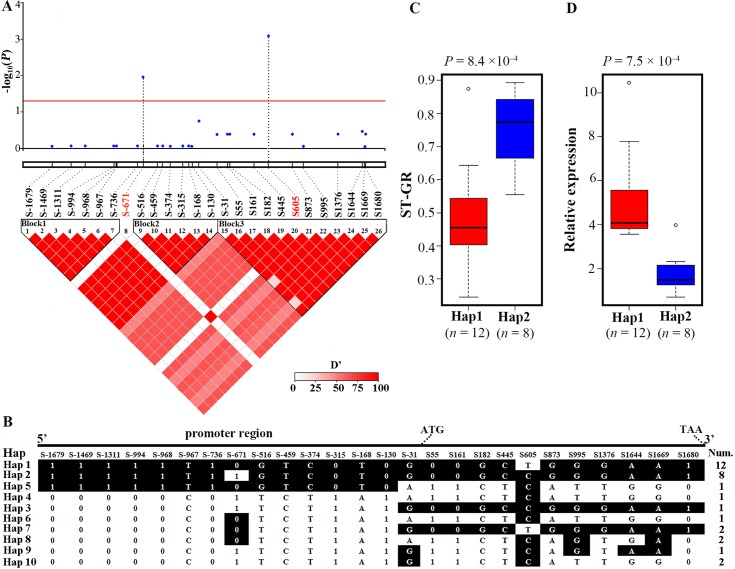
Natural variations in GmCDF1 are significantly associated with salt tolerance indices in 31 soybean accessions.(A)
GmCDF1-based association mapping and pairwise LD analysis (bottom) for GmCDF1. The red solid line represents the significance threshold (−log10(P) = 1.32). The blue dots above the red solid line represent significant variants for ST-GR (P < 0.05), and these are connected to the pairwise LD diagram with a black dashed horizontal line. The inverted triangle is the linkage disequilibrium (LD) plot between the GmCDF1 SNPs. The physical position of each SNP is shown above the plot. The magnitude of LD indexed by the D’ statistic is shown. (B) Haplotypes of GmCDF1 in a subset of 31 soybean accessions. An approximately 4.6-kb genomic region, including the 2.0-kb promoter region of GmCDF1 upstream of the start codon and the 2.6-kb region of GmCDF1 from the 5'-UTR to the 3'-UTR, was used for the haplotype analysis. The haplotypes are displayed as a linear combination of alleles, and ten haplotypes were identified. The major alleles on each polymorphic site are highlighted in black. (C) Comparison of the ST-GR between haplotypes Hap1 and Hap2. n denotes the genotype number of the two haplotypes. Statistical significance was detected by a two-tailed t-test. (D) Comparison of the relative expression of GmCDF1 between haplotypes Hap1 and Hap2. n denotes the genotype number of the two haplotypes. Statistical significance was detected by a two-tailed t-test.